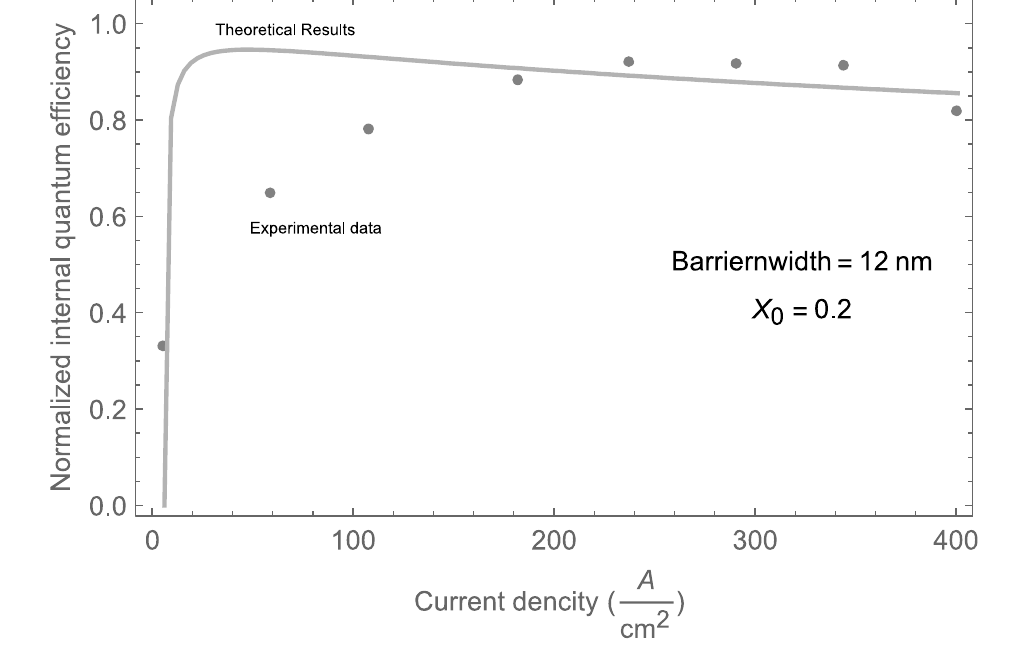
Figure 20. Normalized internal quantum efficiency as a function of current density obtained from the previous study [16], along with the theoretical results.